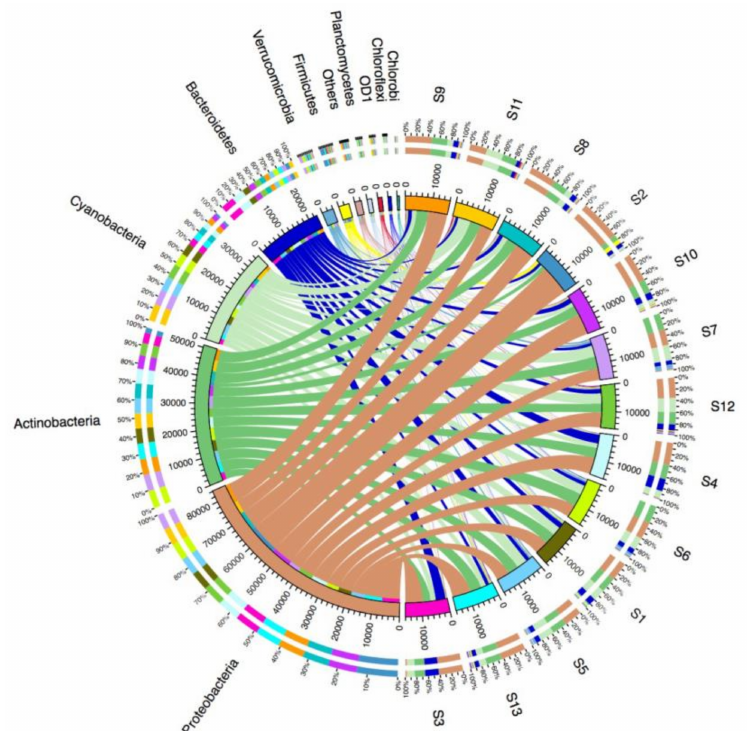
Figure 3. Distribution of phyla in the 13 water samples according to the taxonomic annotations obtained using the Greengenes database and the Ribosomal Database Project (RDP)